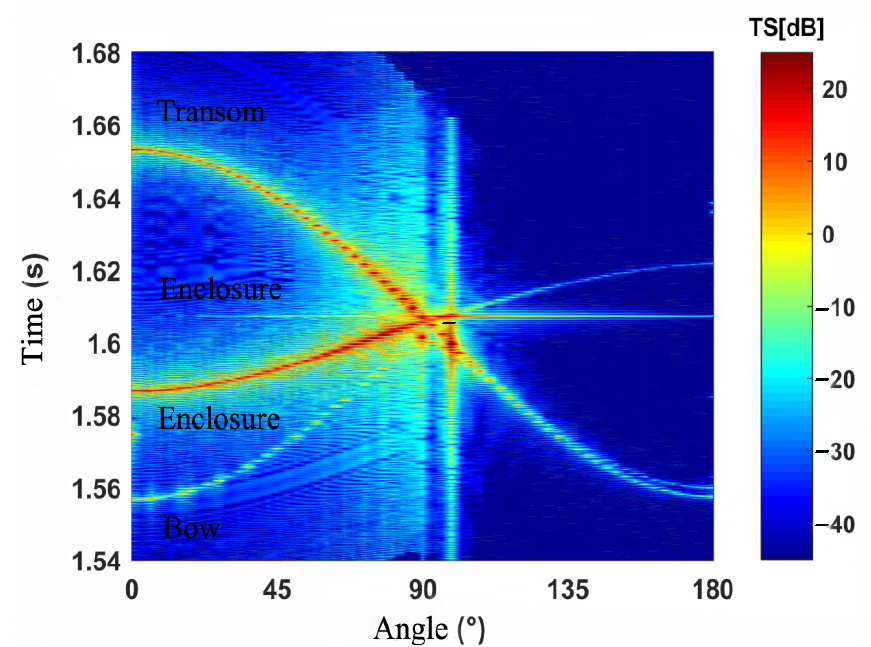
Figure 9. The benchmark submarine target echo.